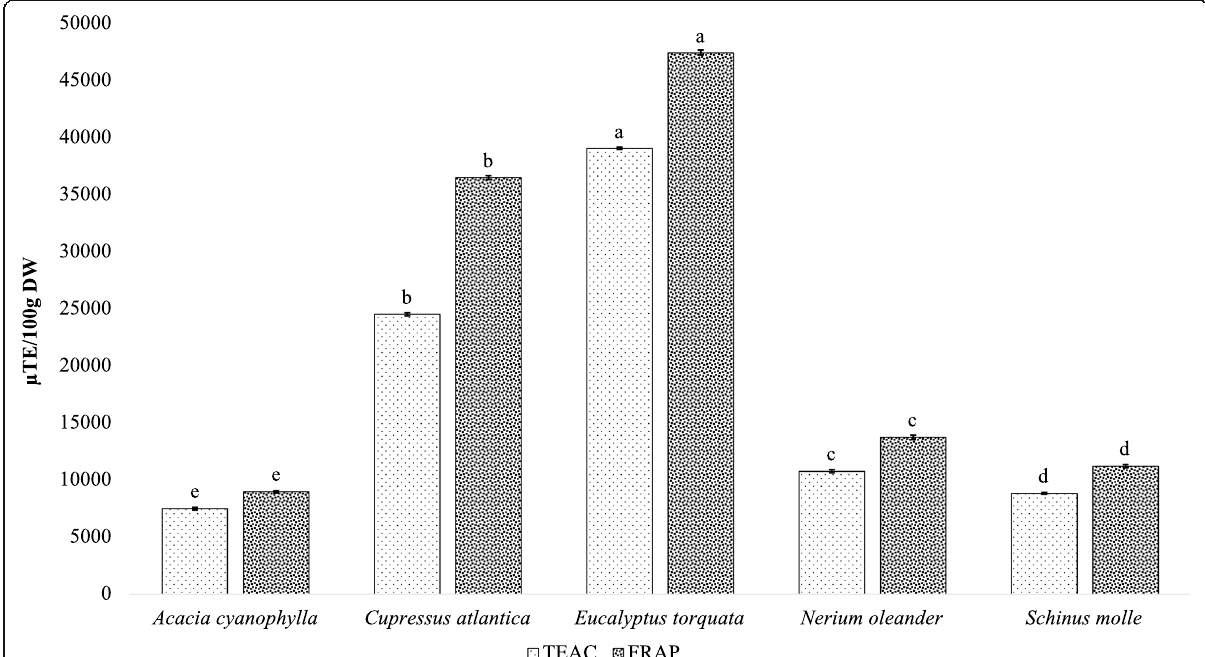
Fig. 5 Antioxidant activity of plant extracts based on TEAC and FRAP assays. Plant species had significant effects on TEAC and FRAP (one-way ANOVA, p < 0.05). Each bar represents the mean of four replicate measurements. Within each antioxidant activity indicator (TEAC or FRAP), different letters above bars indicate significant differences among plant species (Bonferroni tests, p < 0.05). Error bars represent standard